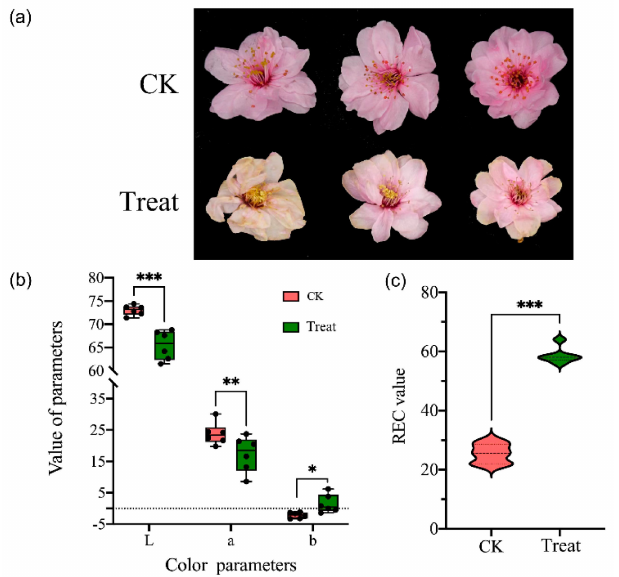
Figure 1. The morphology and color change of Prunus mume flowers in natural temperature (CK, 15 ◦ C) and low-temperature treatment ( − 4 ◦ C). ( a ) The morphology of P. mume flower of control and treatment groups. ( b ) The color parameters (CLE Lab ) of petals of control and treatment groups, L is the lightness, a and b are two chromatic components measured. ( c ) The relative electrical conductivity (REC) of two groups. Significant differences were determined by Student’s t test, p < 0.05 (*), p < 0.01 (**), p < 0.001